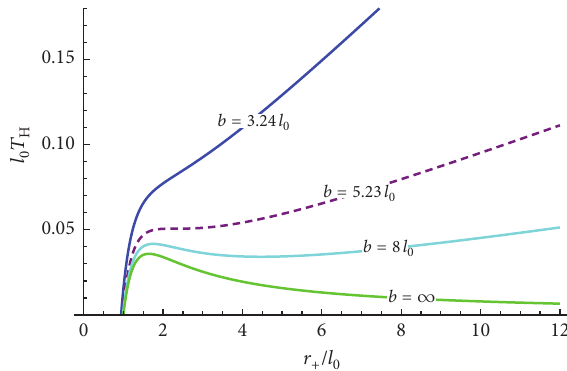
Figure 10: Plot of the Hawking temperature 𝑇 H with respect to 𝑟 + under different vacuum pressure. Particularly, the dashed purple curve corresponds to the case of the critical